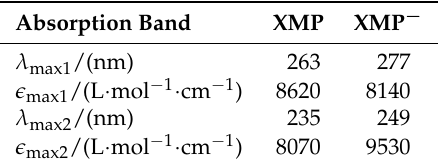
Figure 2. ( a ) Static UV absorption and ( b ) fluorescence spectra of XMP (red) and XMP − (blue). The thin dotted lines in ( a ) show the contributions to the absorption spectra by the S 1 and S 3 bands; the wavelengths in the labels in ( b ) denote the respective pump wavelengths used to record the spectra. Table 1. Absorption maxima and extinction coefficients for XMP and XMP −